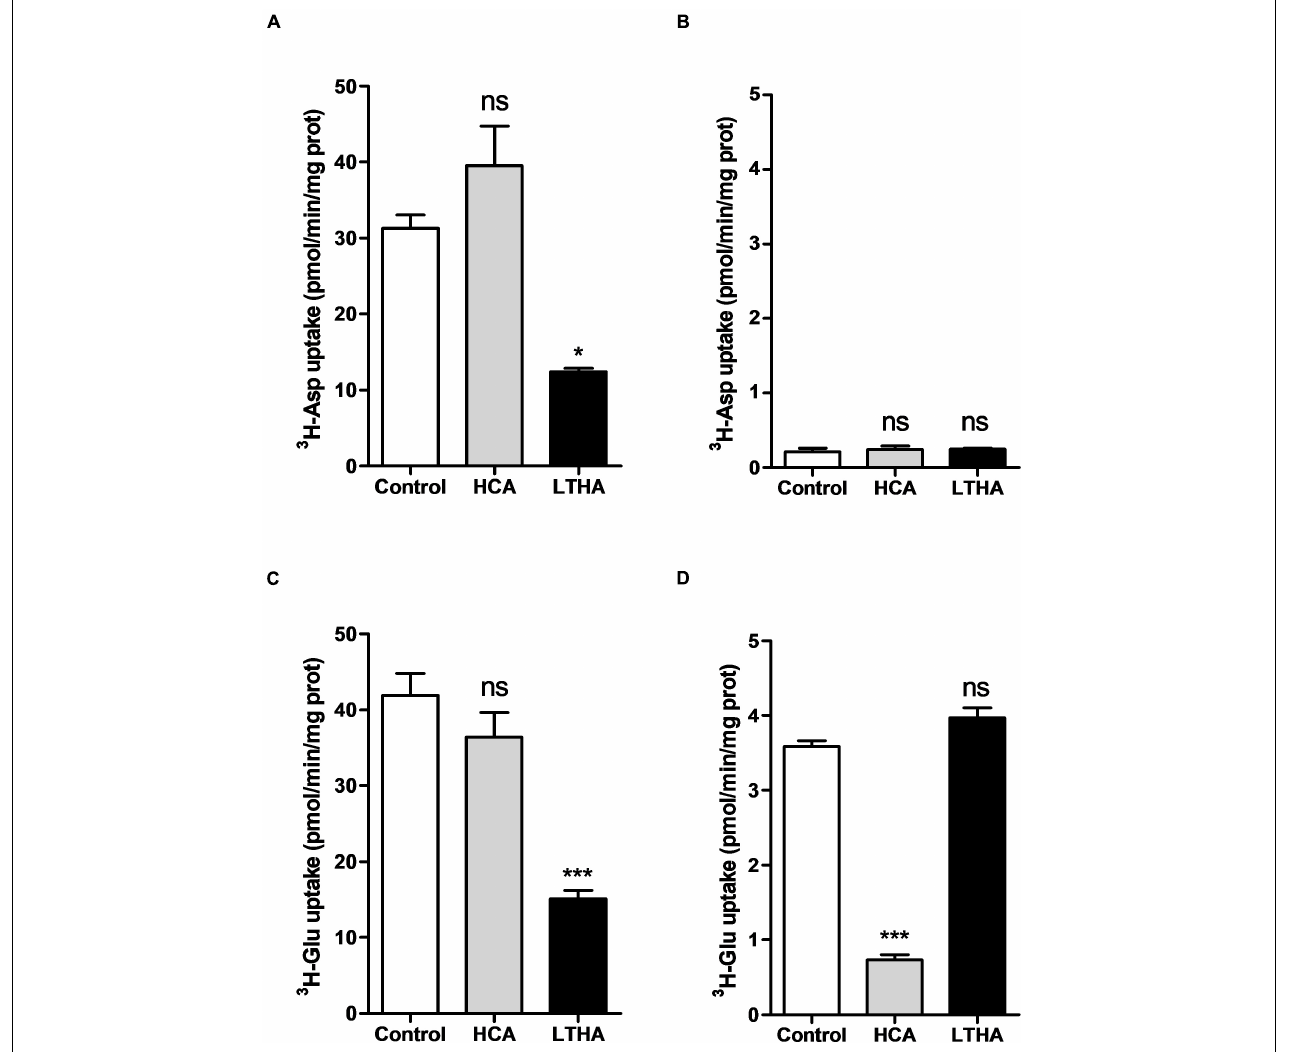
FIGURE 1 | Influence of extracellular Na + on [ 3 H]- D -aspartate and [ 3 H]- L -glutamate uptake in primary cultured rat astrocytes. The [ 3 H]- D -aspartate (A,B) or [ 3 H]- L -glutamate (C,D) uptake assays were performed in Na + -containing (A,C) or Na + -free (B,D) buffers. HCA (10 − 4 M) and LTHA (10 − 4 M) were used to discriminate the involvement of EAATs or system x c − in the uptake. Data shown are the mean with SEM of the uptake capacity from three independent experiments performed in quadruplicate. Statistical analyses were performed using a one-way ANOVA followed by a Dunnett’s test for multiple comparisons (ns p > 0.05, * p < 0.05, *** p < 0.001 when compared to